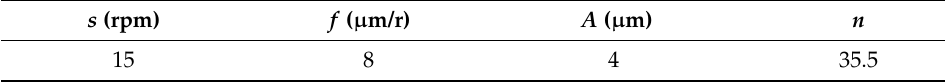
Figure 7. The experiment facility and results: ( a ) Four-axis ultra-precision lathe with self-designed tri-axial FTS; ( b ) Machined hierarchical surface; ( c ) A-A profile; ( d ) B-B profile. Table 3. The parameters used in the experiment.